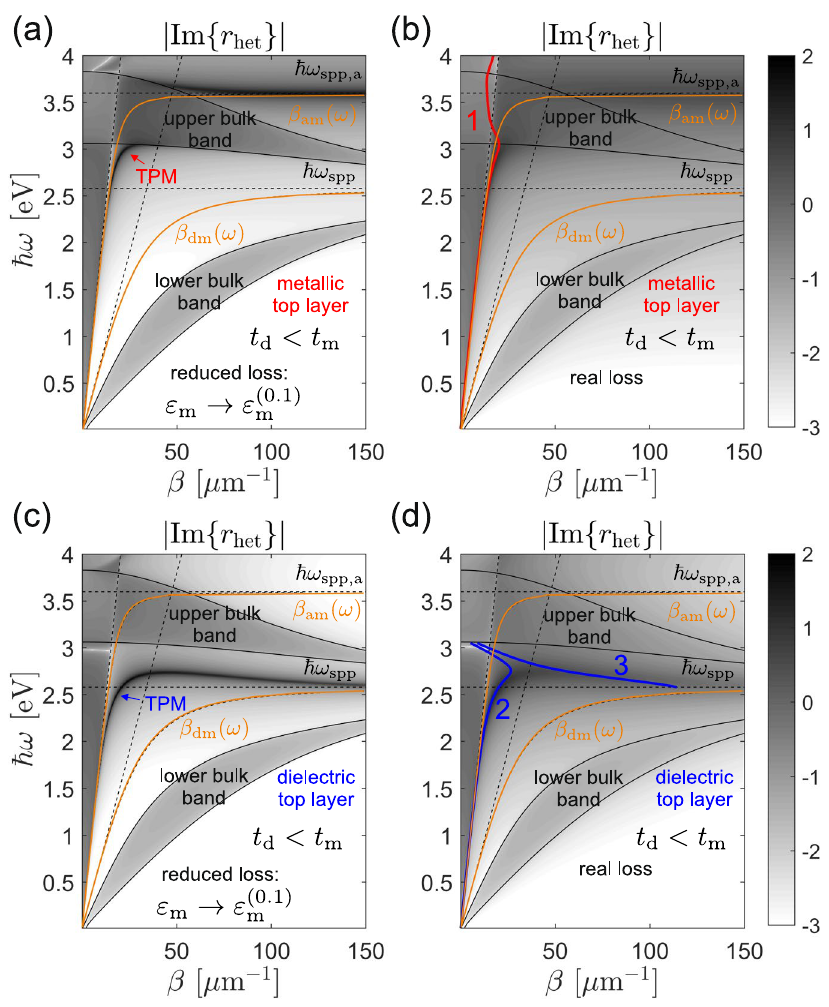
Figure 9. Maps of |Im{ r het }| fully analogous to those drawn in Fig. 7, except that here the t d < t m example is